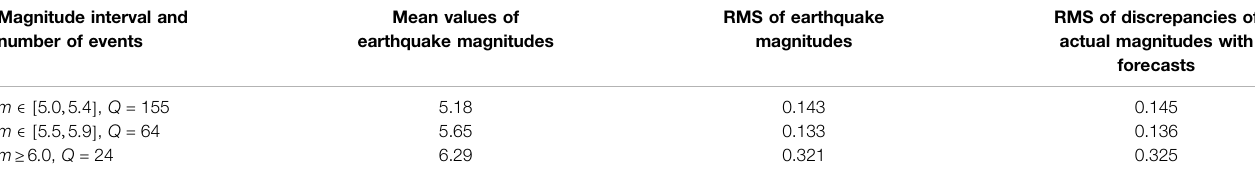
TABLE 3 | Results of forecasting the earthquake magnitudes for